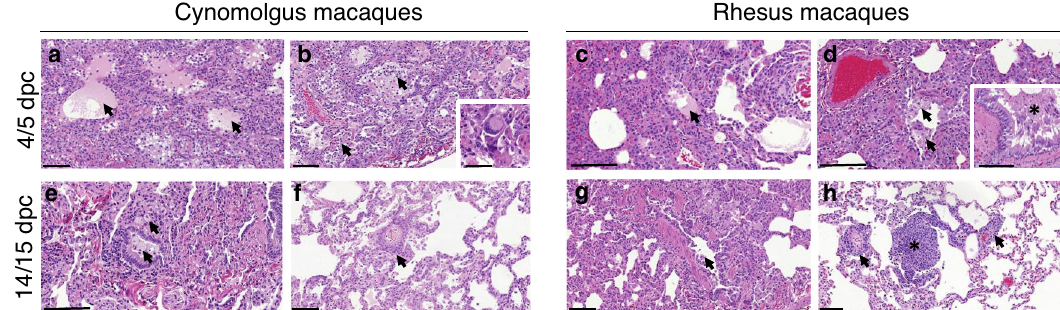
Fig. 4 Histopathological changes in cynomolgus and rhesus macaques during SARS-CoV-2 infection. Areas of alveolar necrosis observed in cynomolgus macaques at 4/5 dpc with shrunken, eosinophilic cells within the alveolar walls ( a , b ), together with alveolar oedema ( a , arrows; bar = 100 µ m), type II pneumocyte hyperplasia and expanded alveolar spaces with in fl ammatory cell in fi ltration ( b , arrows; bar = 100 µ m). Occasional multinucleated cells are observed ( b , insert; bar = 20 µ m). Similar histopathological changes observed in rhesus macaques, including alveolar necrosis and areas with patchy alveolar oedema ( c , arrow; bar = 100 µ m), and accumulatios of alveolar macrophages ( d , arrow; bar = 100 µ m) and bronchial exudates ( d , insert; bar = 50 µ m). Histopathological changes with less severity observed at 14/15 dpc in cynomolgus macaques, with in fi ltration of mononuclear cells within alveolar spaces and bronchiolar lumen ( e , arrows; bar = 100 µ m) and perivascular cuf fi ng ( f , arrow; bar = 100 µ m). Bronchiole regeneration ( g , arrow; bar = 100 µ m) and perivascular/peribronchiolar cuf fi ng observed in rhesus macaques at 14/15 dpc ( h , arrows; bar = 100 µ m), together with BALT proliferation ( h , *; bar = 100 µ m). Representative images from 6 slides per animal at each time point.